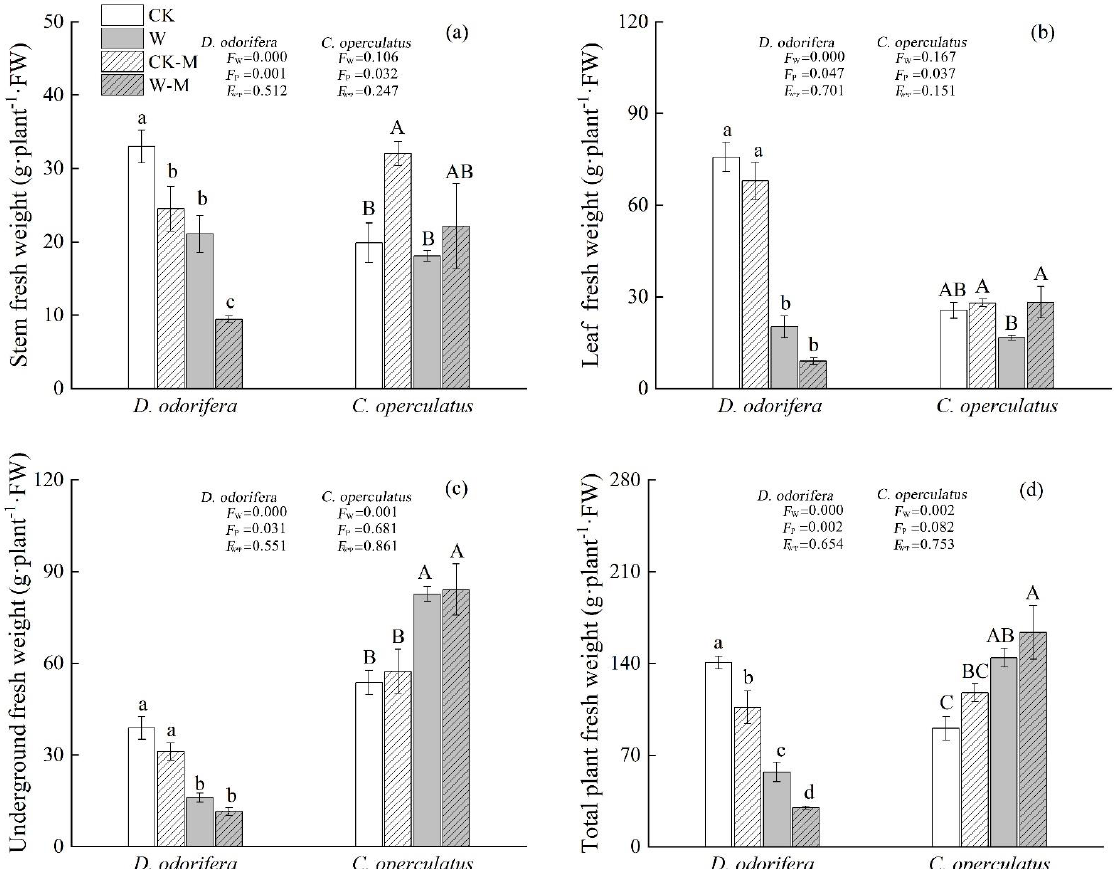
Figure 2. Comparative analyses of the fresh weight of stem ( a ), leaf ( b ), underground ( c ), and total plant ( d ) of C. operculatus and D. odorifera under all treatments. Abbreviations, explanations of treatments, data descriptions, and statistics are the same as those shown in Figure 1.